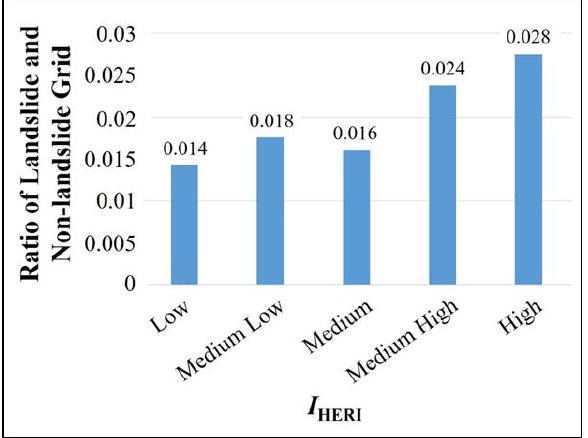
Figure 2. The hazard index I HERI against landslide grid ratio.